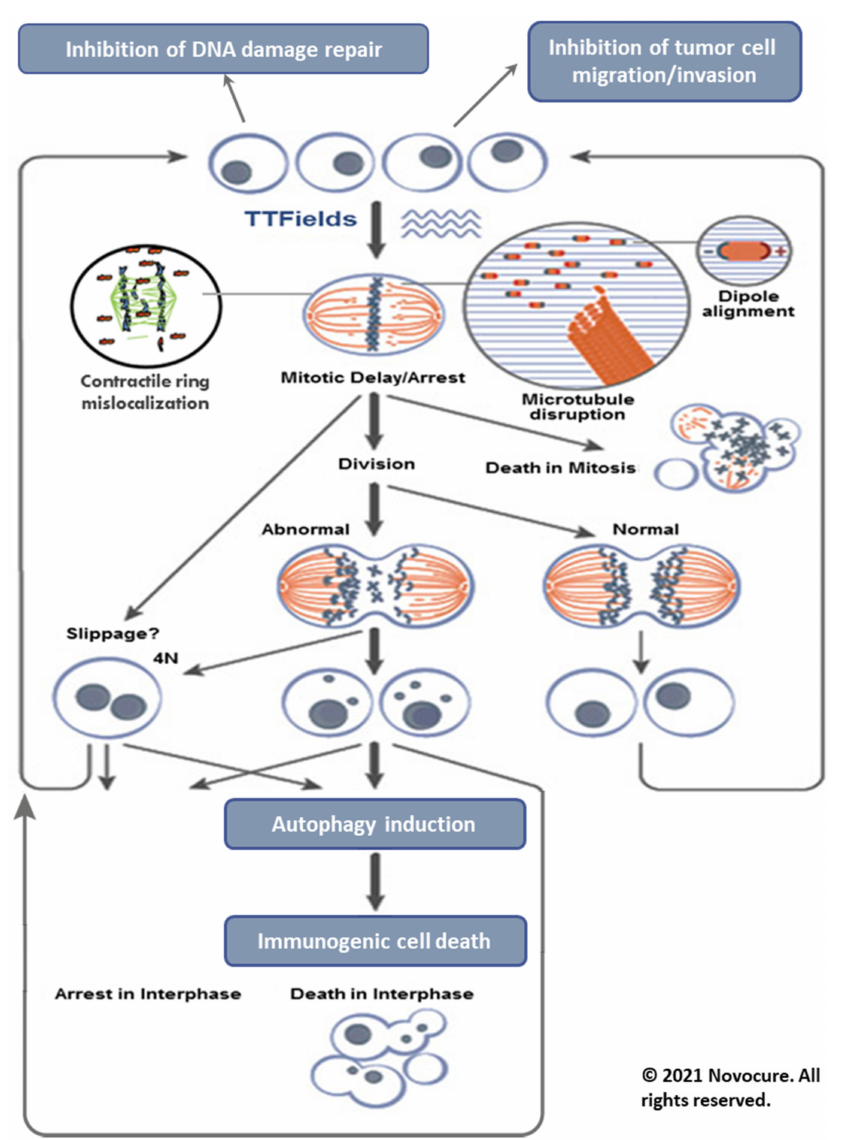
Figure 1. Mechanism of action of TTFields therapy. The TTFields exert directional forces on polar microtubules, interfere with the assembly of the normal mitotic spindle and subsequently trigger mitotic cell death. TTFields also inhibit DNA damage repair, impair cellular migration and upregulate autophagy, resulting in immunogenic cell death. Reproduced with permission from Novocure Inc